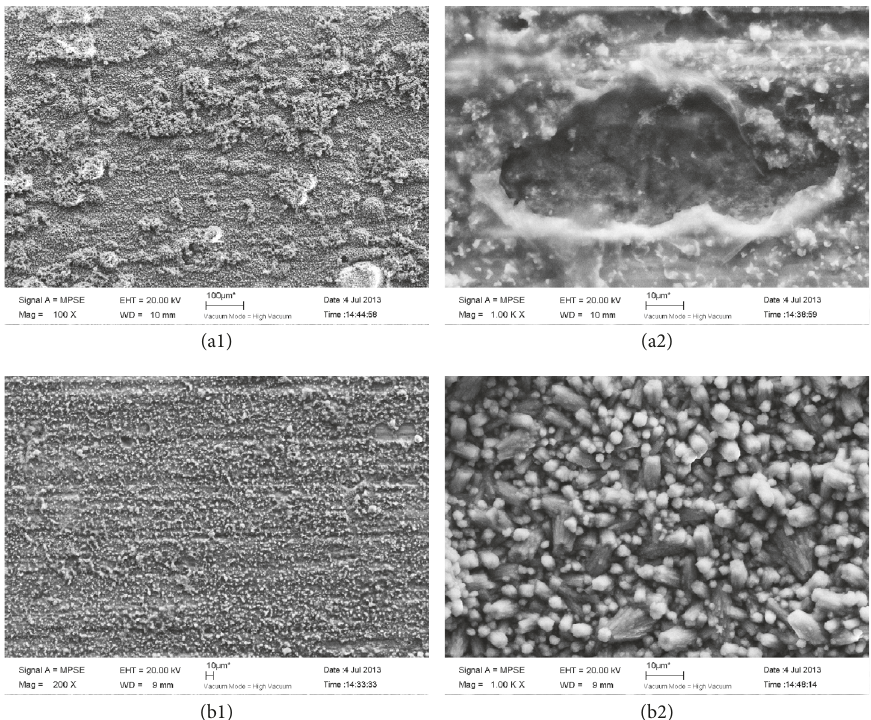
Figure 1: Corrosion morphology of 2024-T31 aluminum-magnesium alloy soaked in different experimental systems for 30 d (1: low magnification observation; 2: high magnification observation).